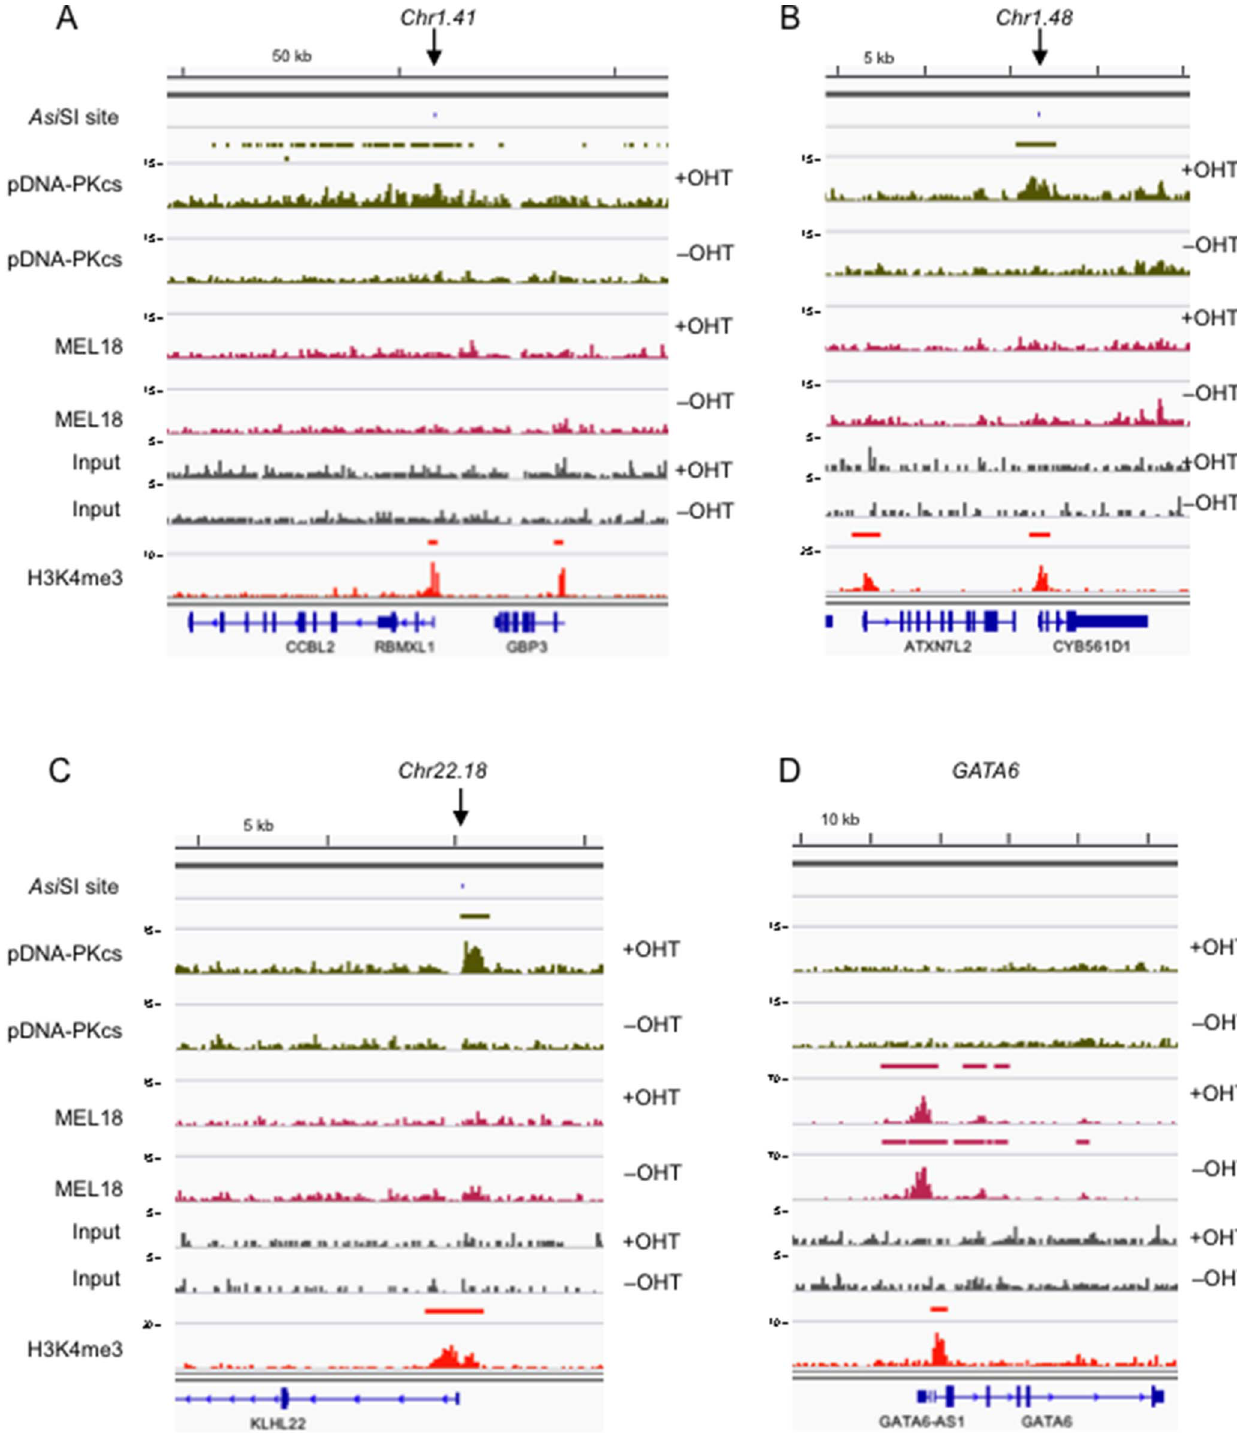
Figure 4. Examples of ChIP-seq data at representative Asi SI sites and PcG target loci. The panels show DNA sequence tag densities following ChIP-seq with the pDNA-PKcs and MEL18 antibodies in Asi SI:ER-transduced Hs68 cells, before and after addition of OHT, as indicated. Input refers to parallel analyses of the chromatin before immunoprecipitation. The maximum coverage for each track is shown on the left of the IGV (Integrative Genomics Viewer www.broadinstitute.org/igv/) screen shot and a size bar is included above. The locations of the Chr1.41, Chr1.48 and Chr22.18 Asi SI sites are identified by a downward arrow (panels A , B and C respectively) and the genomic organization of adjacent RefSeq loci is shown below. GATA6 , a known PRC1 target gene, is included as a positive control (panel D ). The H3K4me3 track refers to genome-wide enrichment of H3K4me3 in the Hs68 strain of HFs from a previously deposited dataset (GEO accession number 40740).